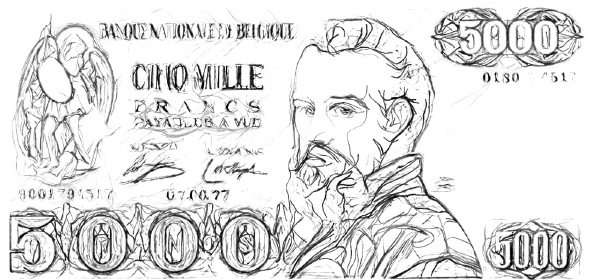
Fig. 5 - Commemorative bill to 500 years of Vesalius (Adapted [11]